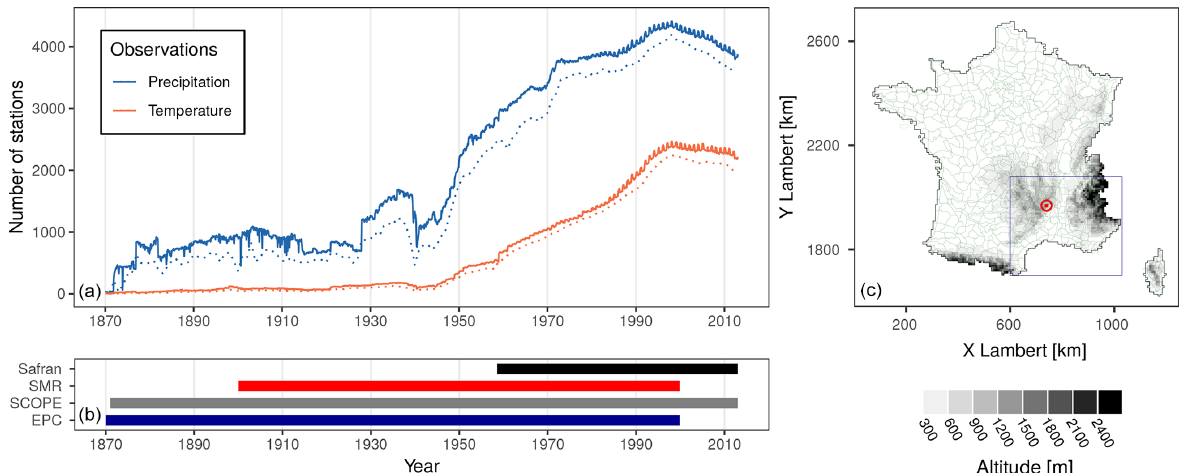
Figure 1. (a) Availability of meteorological observations in the Météo-France database over the 1871–2012 period. Full lines represent the number of open stations during the considered year and dotted lines represent the number of stations with a complete series. (b) Availability of the different gridded datasets: SCOPE Climate, Safran, European pattern climatology, and monthly homogenized series. (c) Map of the 608 climatologically homogeneous zones – in green – as defined in Safran, and altitude of the 8km grid cells of SCOPE Climate and Safran. The case study cell (id: 7548), highlighted in red, is located in the Cevennes area at the altitude of 1165ma.s.l. in a mountainous Mediterranean climate. An observation station (id: 7154005, Mazan-l’Abbaye) is located in this cell at the altitude of 1240ma.s.l. The blue frame represents the study area for the heavy rainfall event of 21 September 1890 (see Sect.